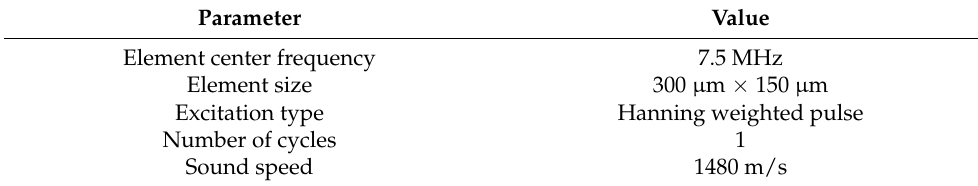
Table 1. Parameters for the directivity pattern